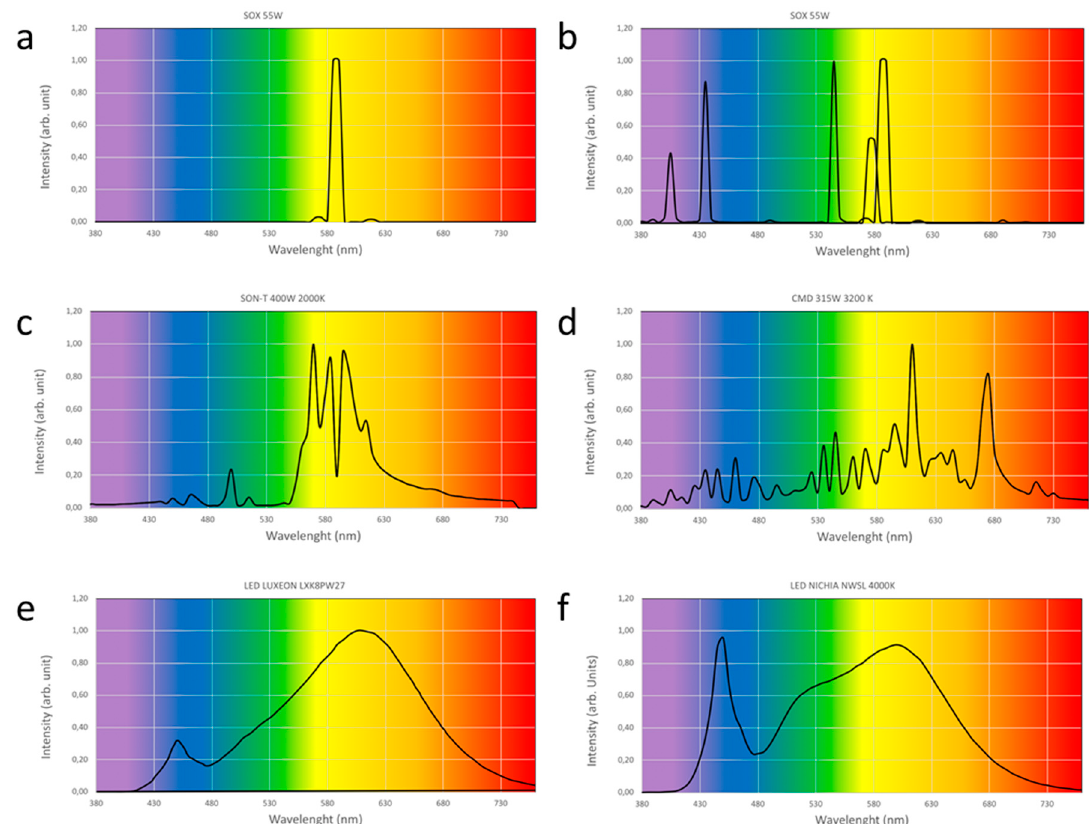
Figure 1. Spectra (visible domain 360 − 780 nm) of some commonly used lamps for outdoor lighting systems. Luminous intensities are normalized to the maximum value: ( a ) low pressure sodium (LPS) lamp (under ban due to eco-conception rules); ( b ) mercury high pressure lamp (MV) (under ban); ( c ) high pressure sodium lamp (HPS); ( d ) ceramic metal halide lamp (MH); ( e ) warm white light emitting diodes (LED) (2700 K); ( f ) cool white LED (4000 K). Spectral data are measured by LAPLACE laboratory (private communication).